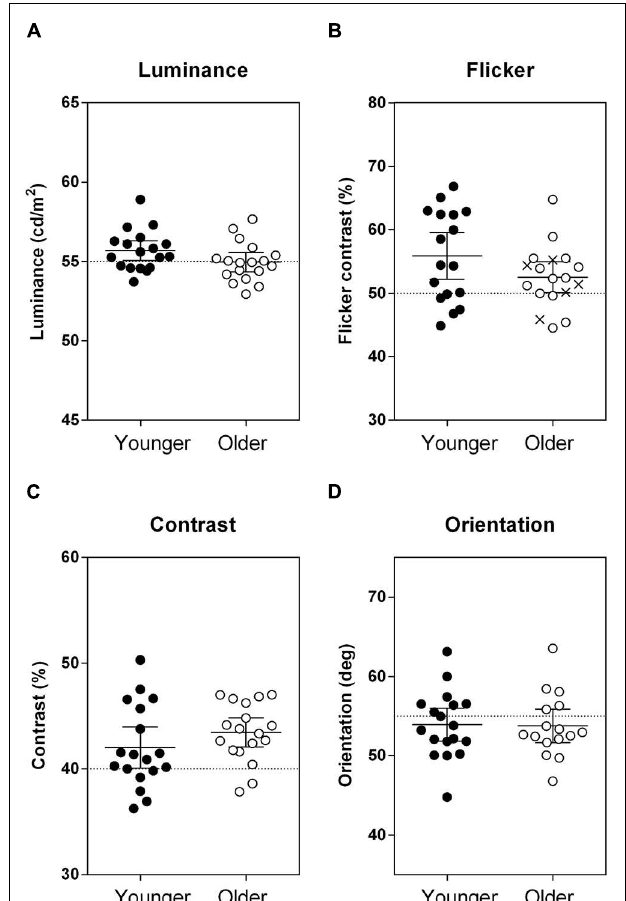
FIGURE 2 | Results from the four ‘no surround’ conditions, where the stimuli were defined by (A) luminance, (B) flicker, (C) contrast, and (D) orientation. Group mean and individual data indicating the perceptual matches are plotted. The cross symbols in Panel (B) are the five individuals who could reliably match the depth of modulation of the flickering target with no surround, but could not perform the ‘surround’ version of the task because of a complete lack of flicker percept. Horizontal dotted lines indicate the veridical property of the target stimulus (A) 55 cd/m 2 , (B) 50% depth of modulation, (C) 40% contrast, and (D) 55 ◦ anticlockwise from horizontal meridian. Error bars are the 95% confidence limits of the mean. There was no overall difference in matching percepts between the groups across all of the tasks, F (1,34.66) = 0.79, p =